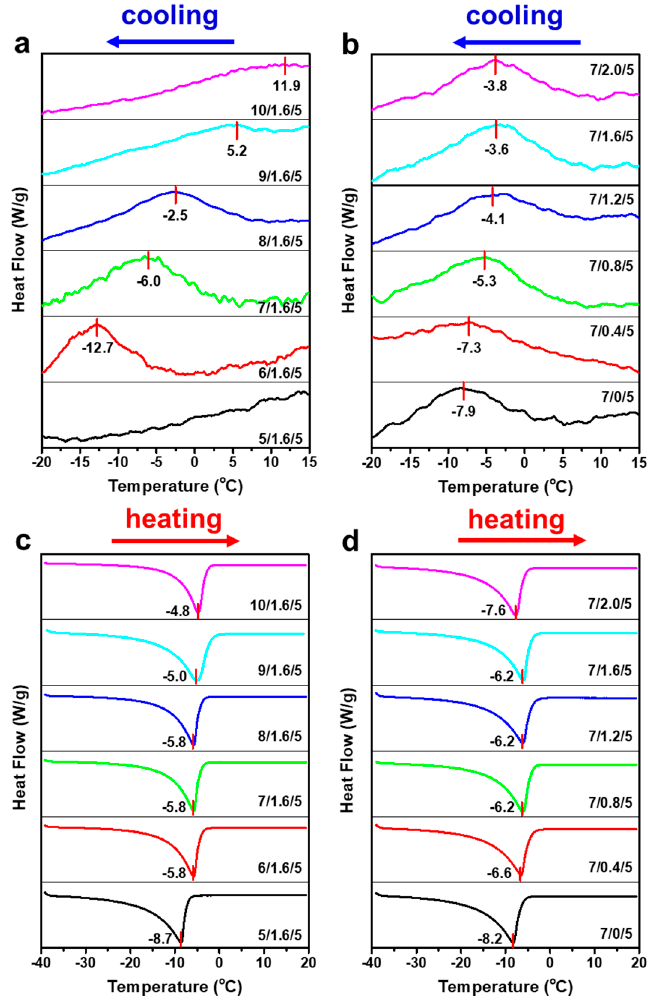
Figure 2. Magnified DSC ( a , b ) cooling and ( c , d ) heating thermograms of 5 wt% CC in NaOH/ZnO aqueous solutions with various NaOH and ZnO contents.